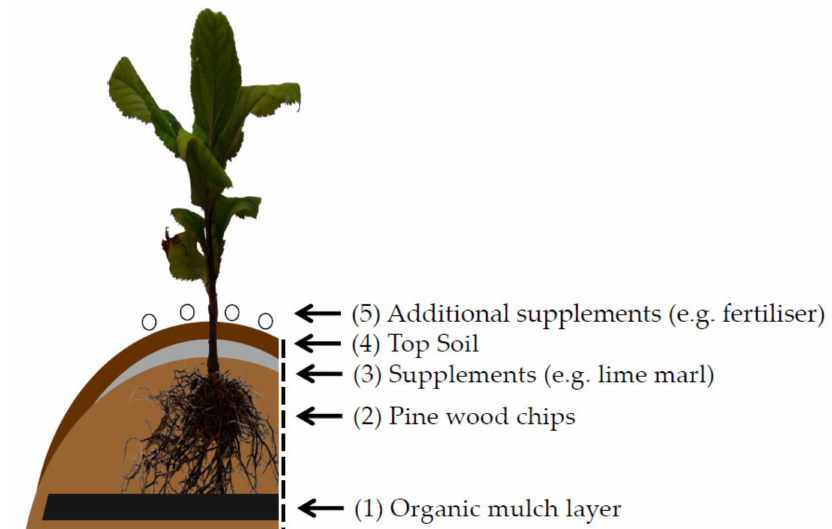
Figure 1. Formalised layers of the MDK ridge for treatment at time of planting. Adapted from Diehl et al., 2020 [20].